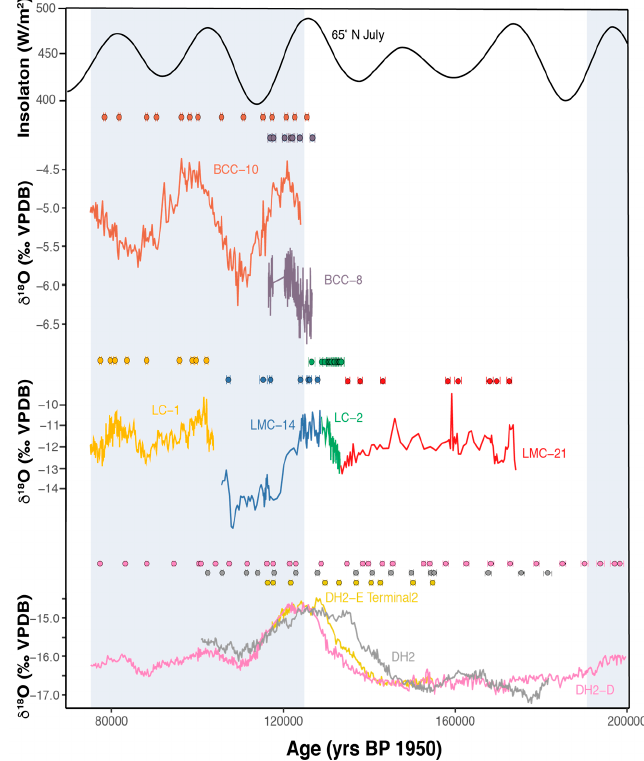
Figure 5. Speleothem records covering MIS5 to MIS7 that are included in SISAL_v1. These include vadose zone (LMC and LC records [47,111] which comprise the Leviathan Chronology) and phreatic deposits from western North America (DH records [96]), as well as records from the eastern United States (BCC records [112]), and the record of July insolation at 65 ◦ N [113]. Ages (solid circles) and associated uncertainties are shown with each record. Interglacial periods MIS5 and MIS7 are shaded